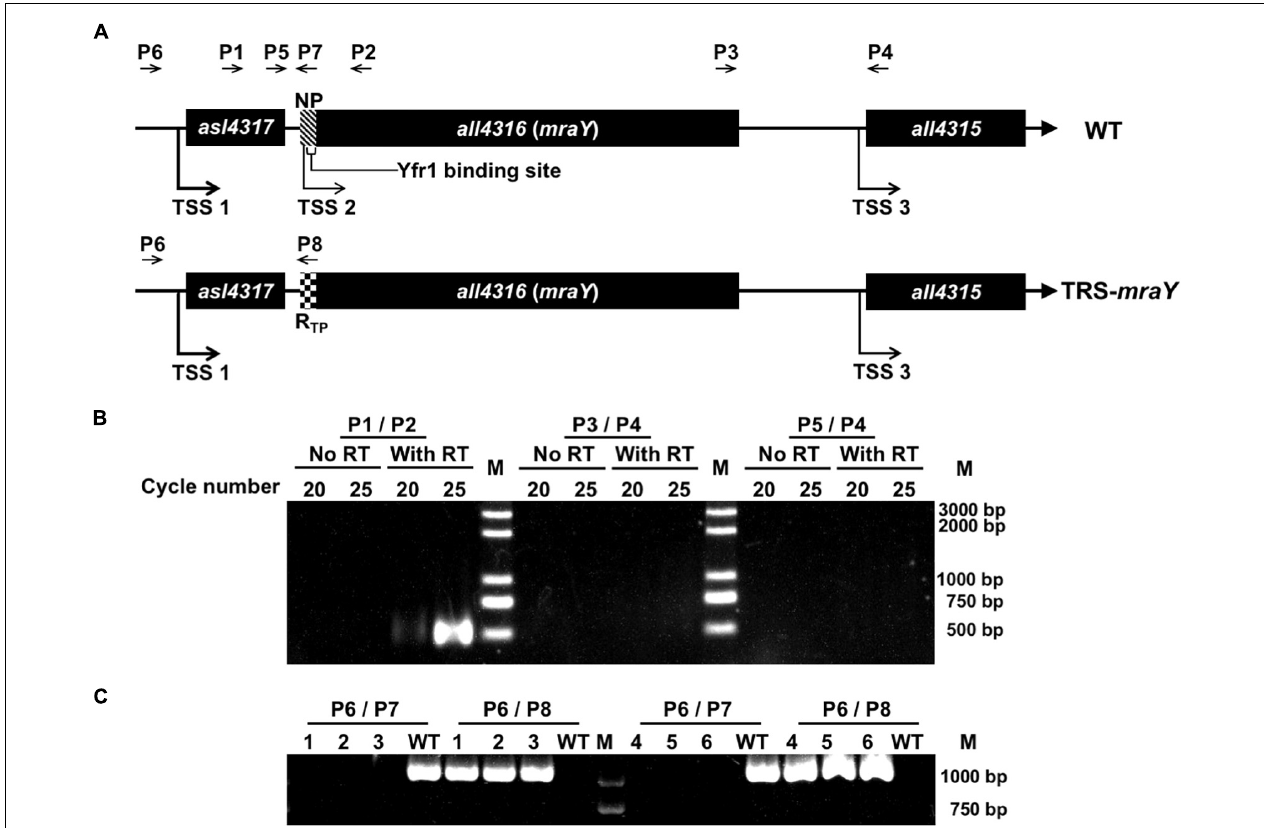
FIGURE 1 | Construction of the conditional mutant of mraY using CRISPR-Cpf1. (A) The schematic representation of the genotype of wild-type Anabaena (WT) and the TRS- mraY strain, and their surrounding genetic context. NP, native ribosome binding site (–39 to –1 bp) of mraY . R TP , theophylline riboswitch. Yfr1 binding site, at –23 to –6 bp of mraY , is also shown. The thickness of the arrow represents the relative strength of the transcription starting site (TSS), based on published RNA seq data (Mitschke et al., 2011). The relative position of different DNA primers (P1–P8) used are shown. (B) RT-PCR for the mraY gene cluster. P1, P2, P3, P4, and P5 (see A for their relative position) correspond to oligonucleotides Pall4316F280m, Pall4316R220, Pall4315F452m, Pall4315R48, and Pall4315F1702m, respectively. The expected size of the RT-PCR product amplified from the WT genome with P1 and P2 or P3 and P4, is 500 bp, respectively, and that amplified with P5 and P4 is 1,750 bp. 20 and 25 correspond to the number of PCR cycles used for amplification. (C) Verification on the genotype of TRS- mraY (clones 1-3) and ftsZ-cfp :TRS- mraY (clones 4–5) by PCR using the primers as shown in (A) . P6, P7, and P8 are the oligonucleotides Pall4316F1047m, Pall4316R1m, and PV-19, respectively. Three independent colonies grown up on the conjugation plates were examined. The expected size of the PCR product amplified from the WT genome with P6 and P7 is 1,047 bp, and with P6 and P8 is 0 bp. The expected size of the PCR product amplified from TRS- mraY mutant with P6 and P7 is 1,071 bp, and no product should be amplified with P6 and